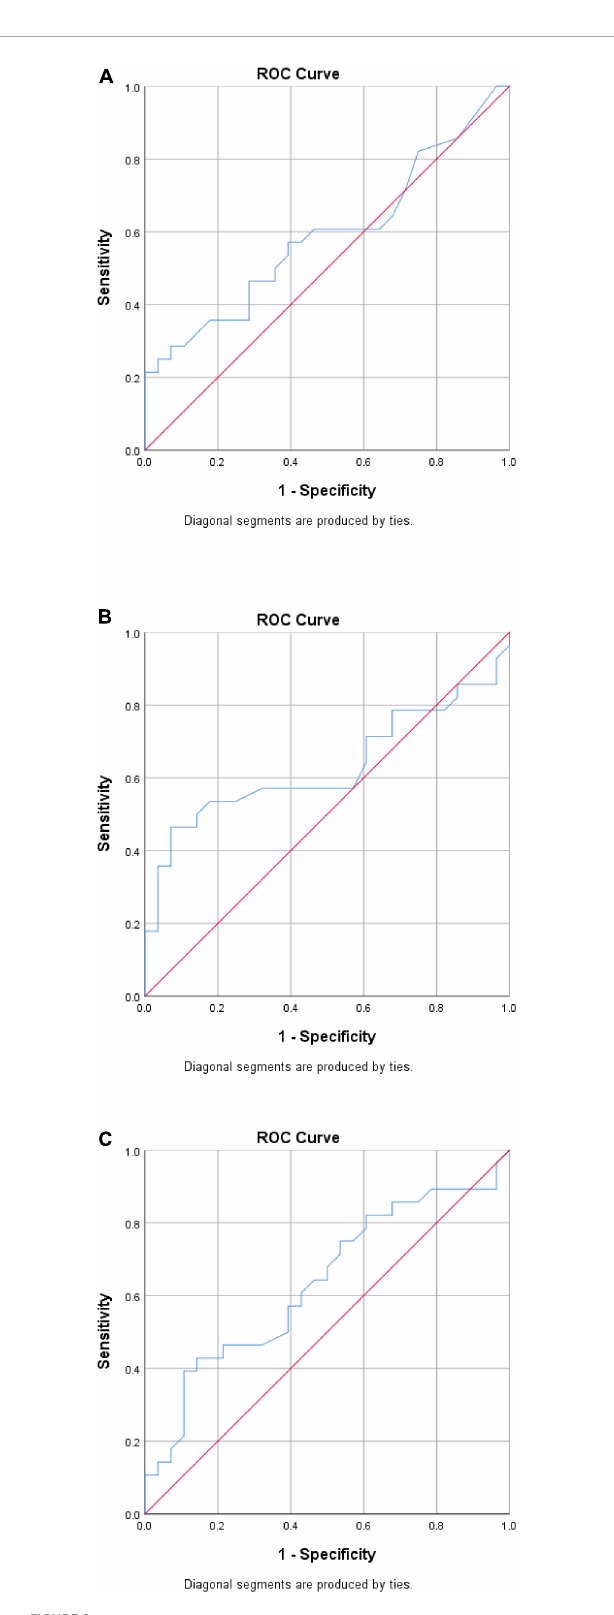
FIGURE2 Exploratory receiver operating characteristic (ROC) curve analysis. (A) Proximal AT. AUC = 0.589 (95% CI 0.437, 0.740), p = 0.255. (B) Mid-AT. AUC = 0.631 (95% CI 0.477, 0.784), p = 0.093. (C) Distal AT. AUC = 0.635 (95% CI 0.488, 0.782), p = 0.082. CI, confidence interval; AUC, analysis of the area under the